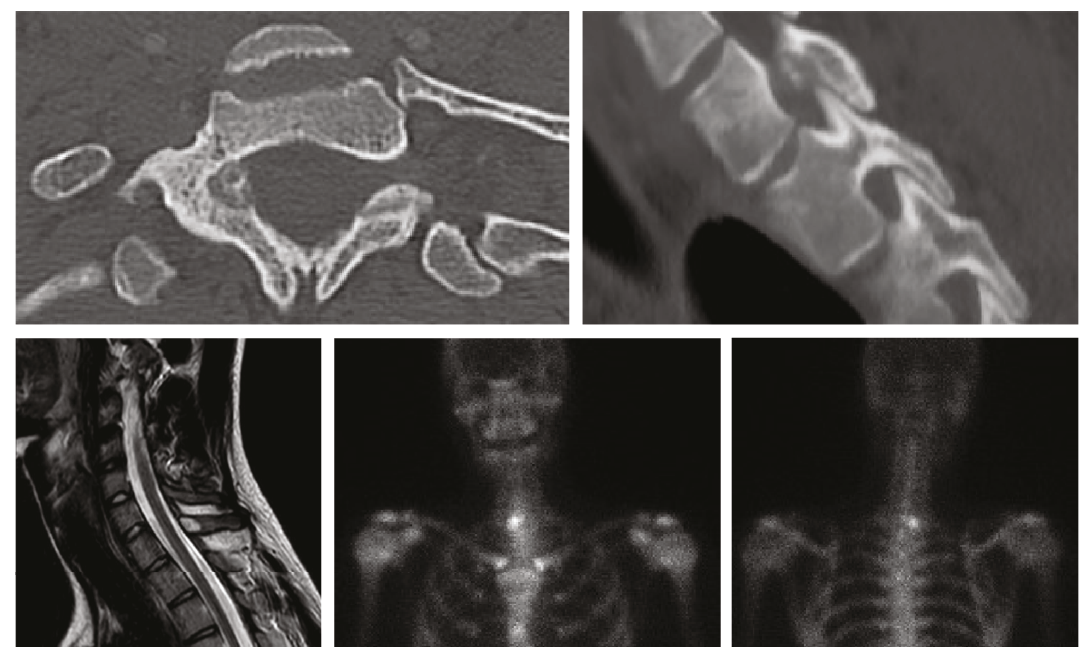
Figure 1: CT scan and MRI of the spine and bone scan. The CT scan shows a rounded osteolytic lesion surrounded by sclerotic bone. Its size is inferior to 15 mm of diameter, within a nidus. MRI shows a T2 hypersignal and a T1 hyposignal on the right side of the T1 vertebra, until the vertebral body with an attachment to the pedicle, and an in fl ammation of the right T1 root. The bone scan shows hyper fi xation of the right T1 vertebra